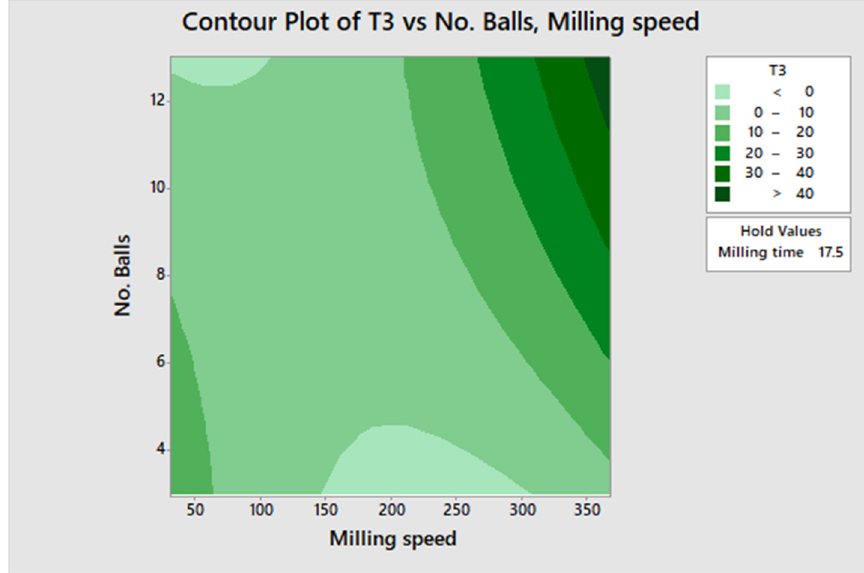
Figure 13. T3 vs. no. of balls– milling speed.